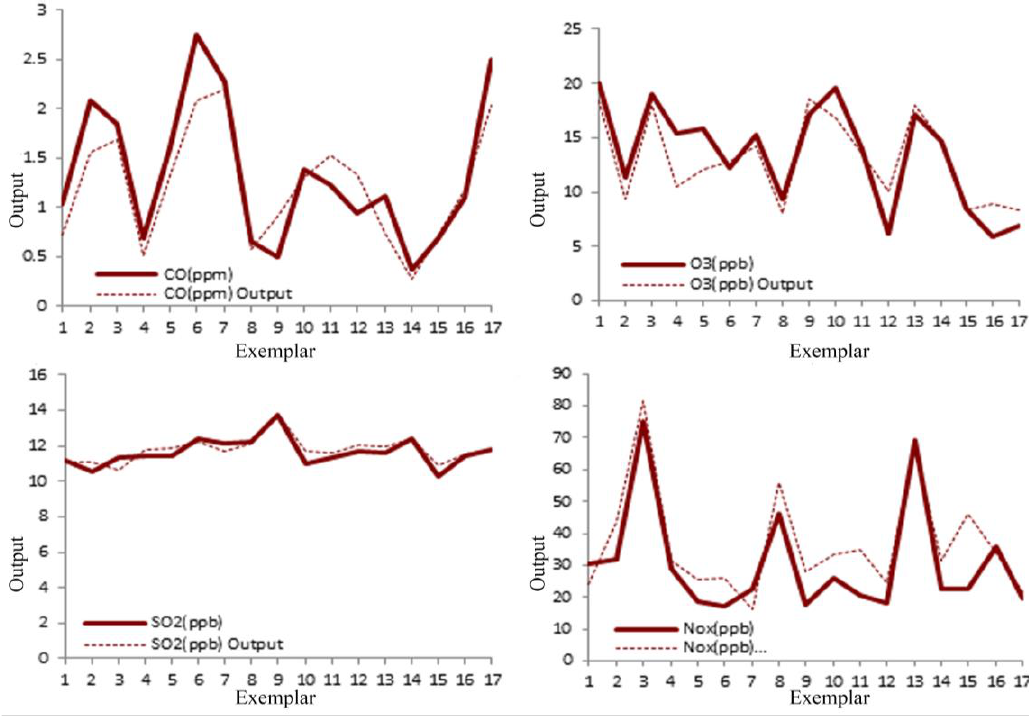
Fig. 4. Desired output and actual network